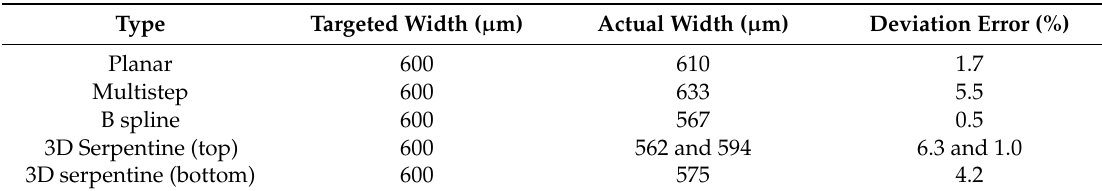
Table 1. Summary of lateral dimension of the fabricated micromixers.